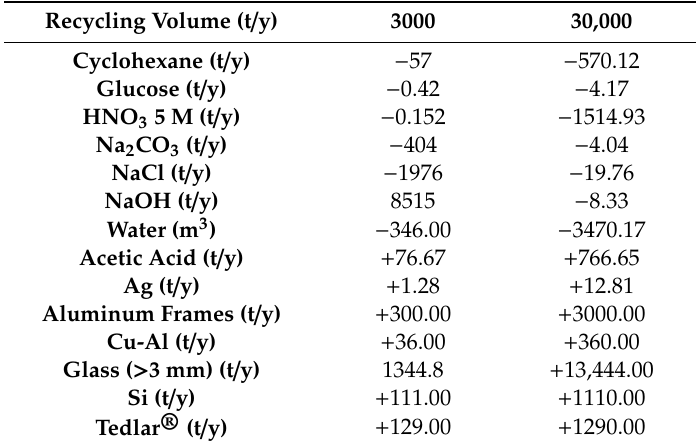
Table 7. Material balance of the process for the two recycling volumes (negative values represent consumed materials whereas positive values represent produced